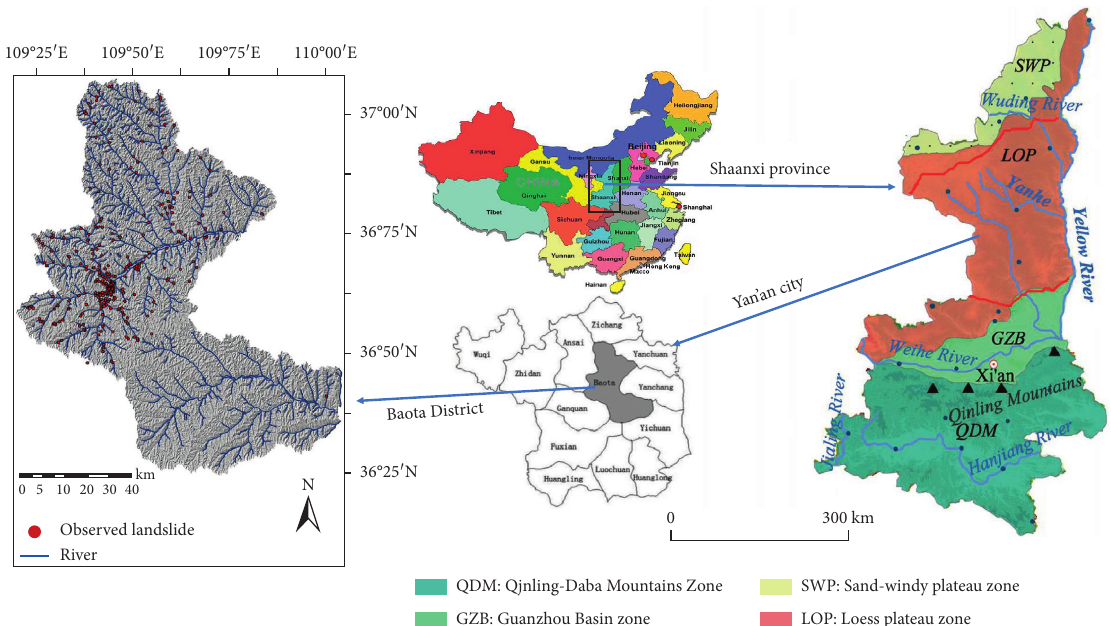
Figure 1: Location of the study area: Baota District, Yan’an city.